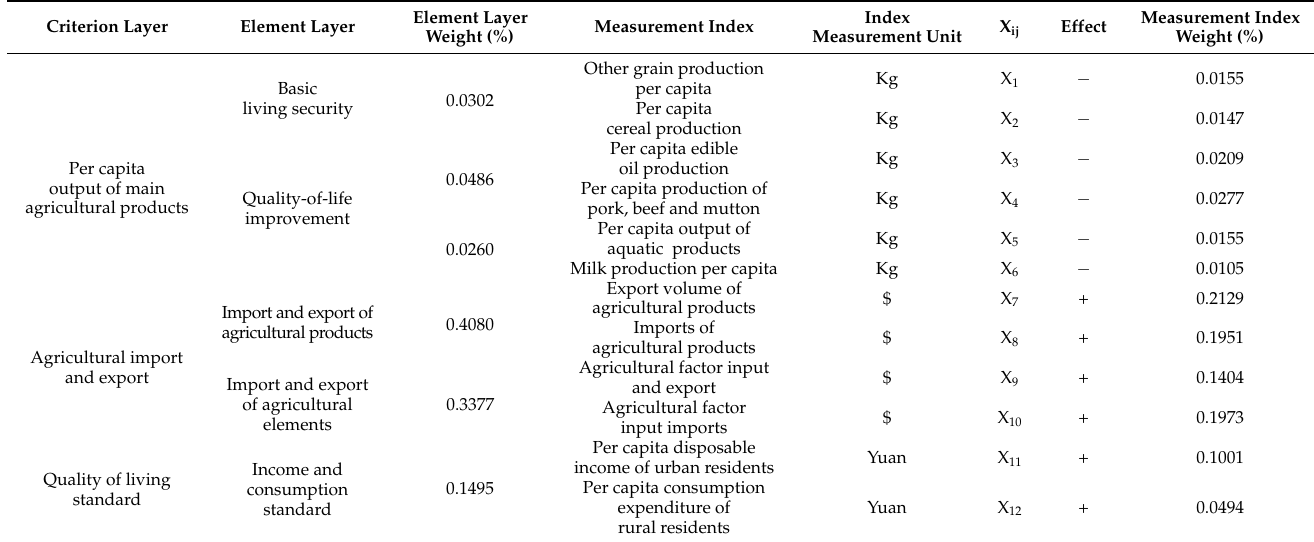
Table 2. Measurement system of China’s agriculture opening-up.